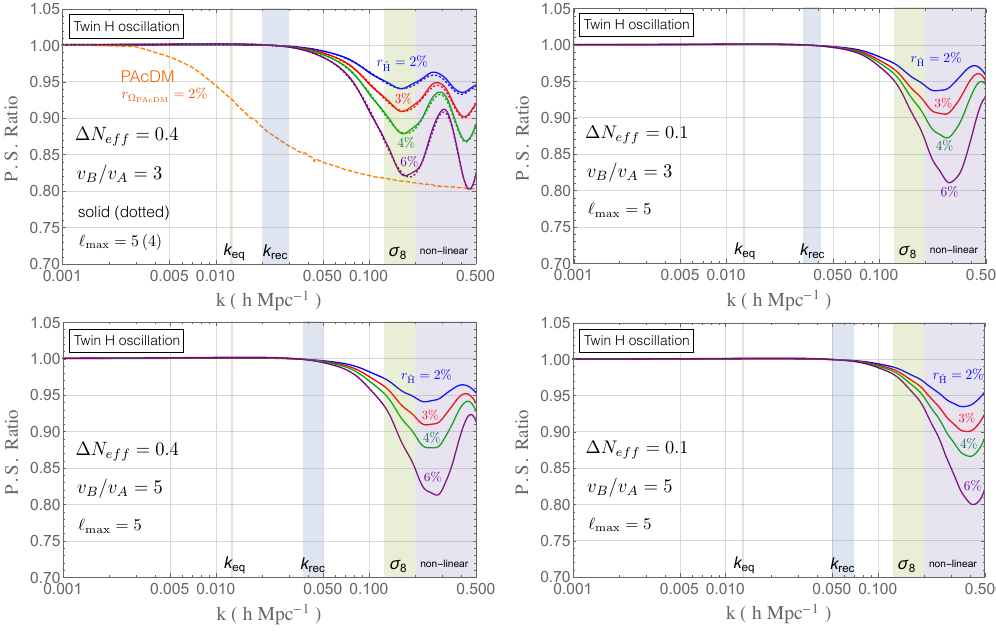
Figure 3 . Ratio of matter power spectrum between (cid:3)CDM+MTH and (cid:3)CDM+DR, both with (cid:1) N e(cid:11) = 0 : 4 (left) and 0.1 (right) for v B =v a = 3 (top) and 5 (bottom). Here we neglect the e(cid:11)ect of twin Helium on the oscillation, assuming it is absent or has recombined much earlier. The orange dashed-dotted curve is from the PAcDM model [67], in which a sub-component dark matter never decouples from the dark radiation scattering. For the MTH results, the solid (dotted) curves come from solutions of linearized Boltzmann equations discussed in section 3 with the inclusion of Boltzmann hierarchy modes up to ‘ max = 5 (4). The vertical k rec band corresponds to the values of k at the time of twin recombination over the range of r ^H considered in the plot. The line k eq corresponds to the k value of (cid:13)uctuation mode that enters at matter-radiation